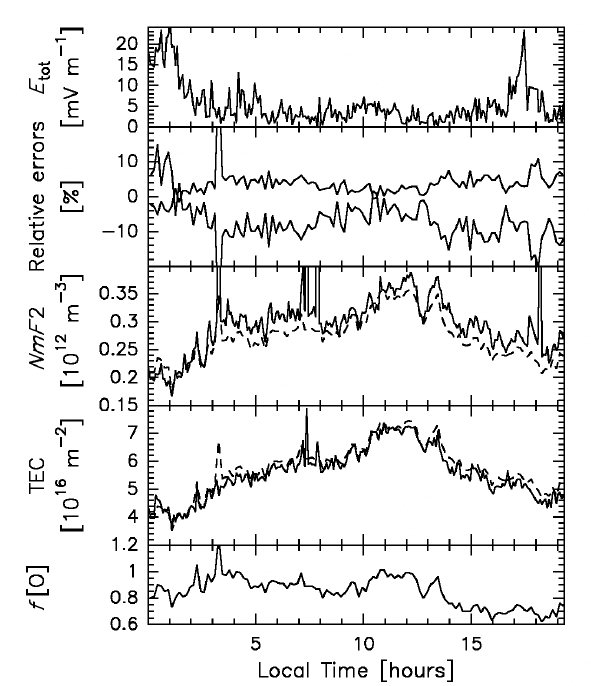
Fig. 4.1. Total electric field measured by EISCAT ( top panel). The NmF 2 and ITEC variations are shown in the third and fourth panels. Bold lines are the measurements and the thin lines are the fits with a correction factor for the atomic oxygen density. Second panel gives the relative errors for NmF 2 (upper line) and for ITEC (low- er line). The bottom panel shows the values of the time varying correction factor for atomic